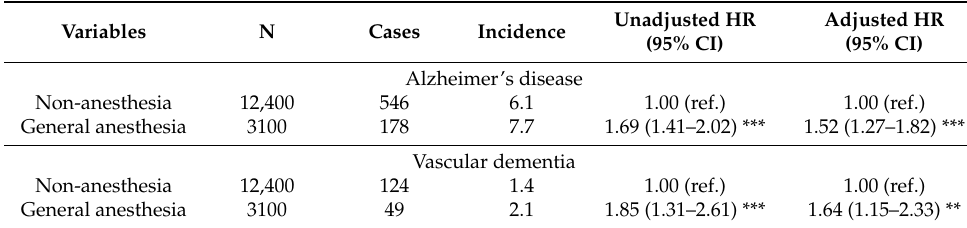
Table 5. Incidence per 1000 person-years and the HRs (95% CI) for Alzheimer’s disease and vascular dementia.